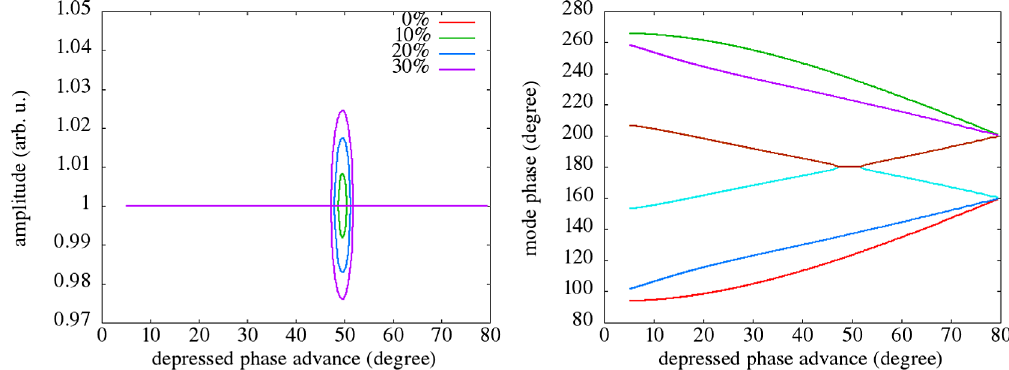
FIG. 13. The 3D envelope mode (left) growth rate amplitudes and (right) phases as a function of the transverse depressed phase advance with 10%, 20%, and 30% deviations from the original rf cavity setting in a periodic quadrupole-rf channel. The six colors in the right plot are the phases of the six eigenvalues.